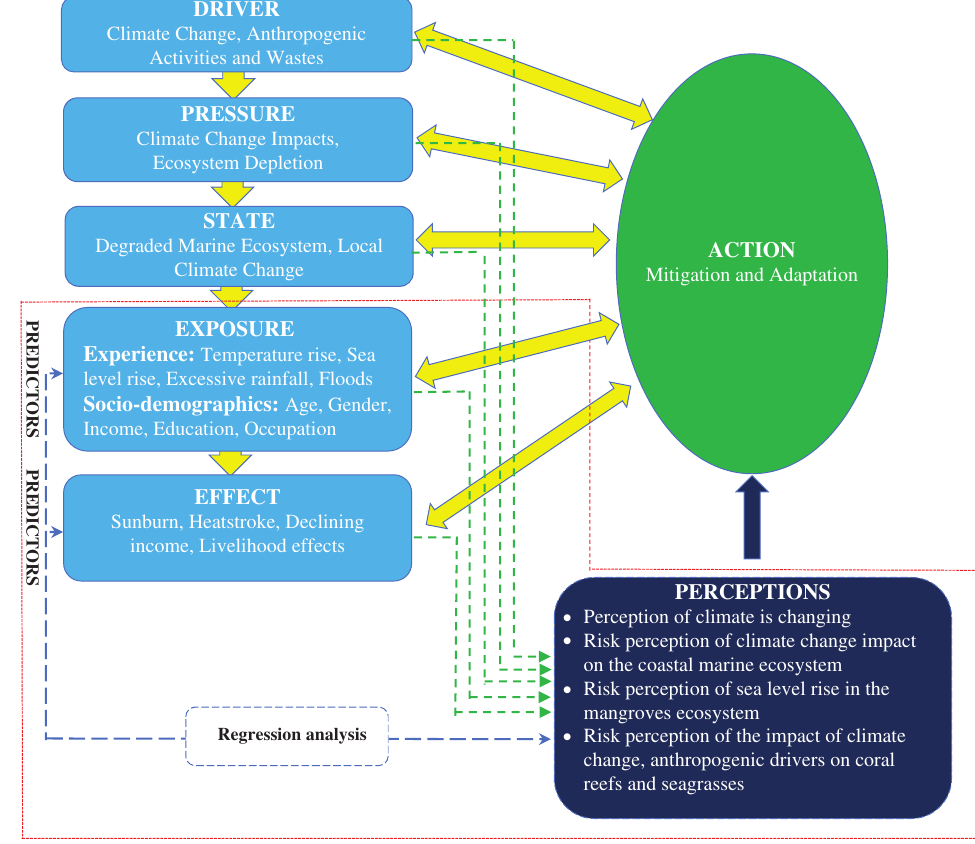
Figure 2 Conceptual framework used in data analysis of the relationship between predictors and risk perceptions of climate change impacts based on the eDPSEEA model. (Analysis is focused only on the highlighted, red-dotted line.) (Source: Authors,